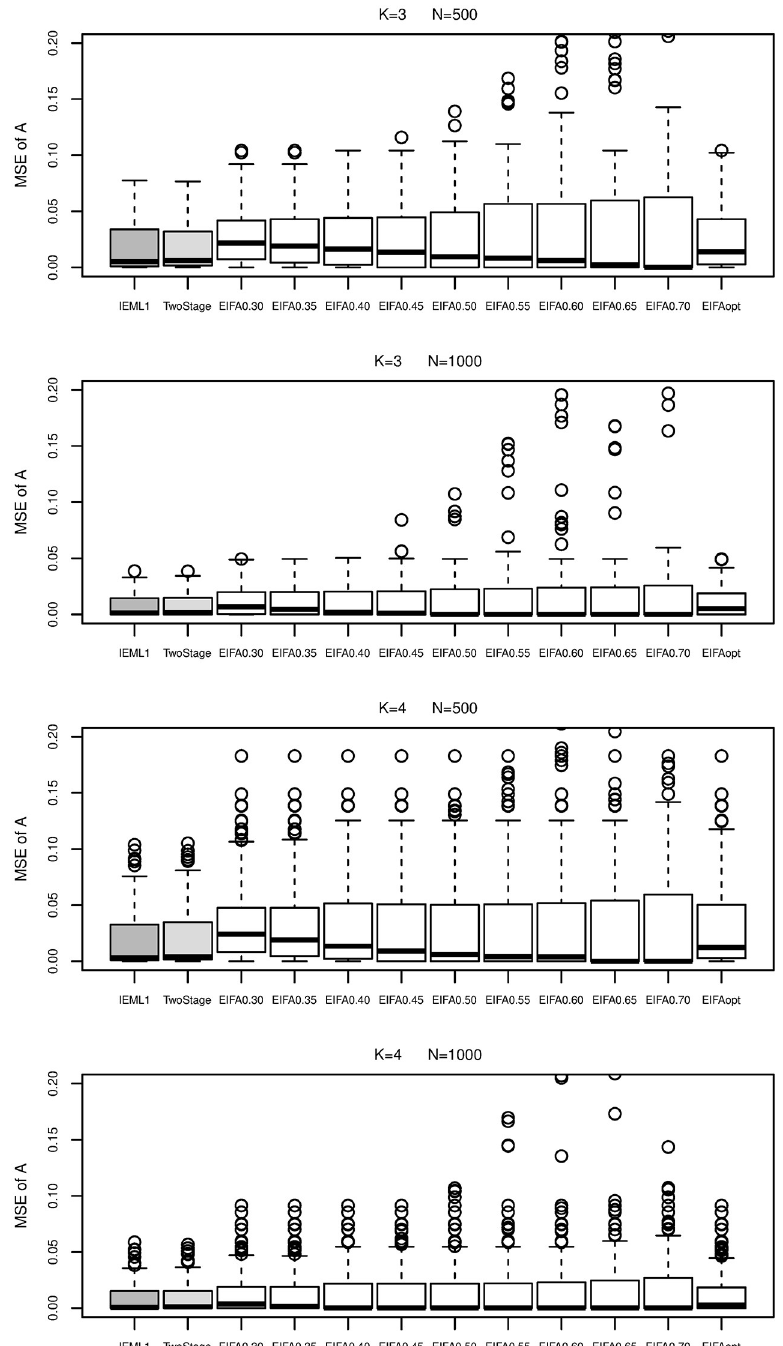
Fig 4. Boxplots of the MSE of A obtainedby IEML1 (dark gray boxes), two-stage(light gray boxes), EIFAthr and EIFAopt (white boxes) for K = 3 and 4 under sample size N = 500 and 1000.